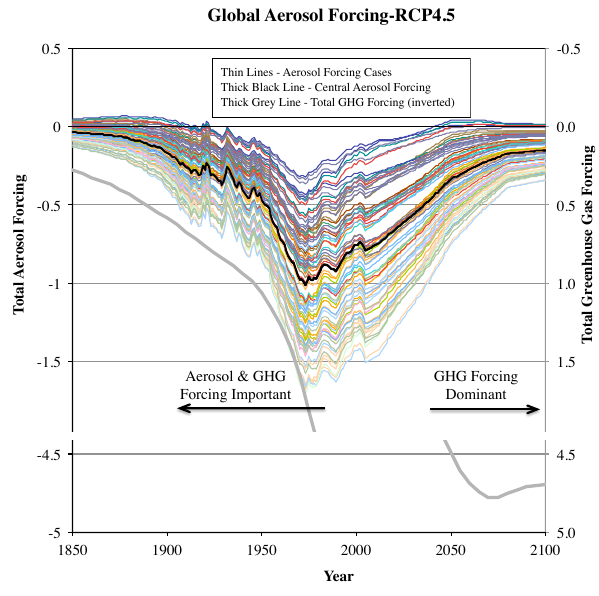
Fig. 4. Total aerosol forcing, including sulfate, black carbon, or- ganic carbon, and cloud indirect, for different combinations of cur- rent period forcing assumptions as shown in Table 1 for the RCP4.5 policy scenario (with different colors for each forcing combination). The central forcing case is shown as the thick black line, and global forcing from greenhouse gases (CO 2 , CH 4 , N 2 O, halocarbons, and tropospheric ozone) is also shown for comparison on an inverted scale. Note the post-2050 change of vertical scale for GHG